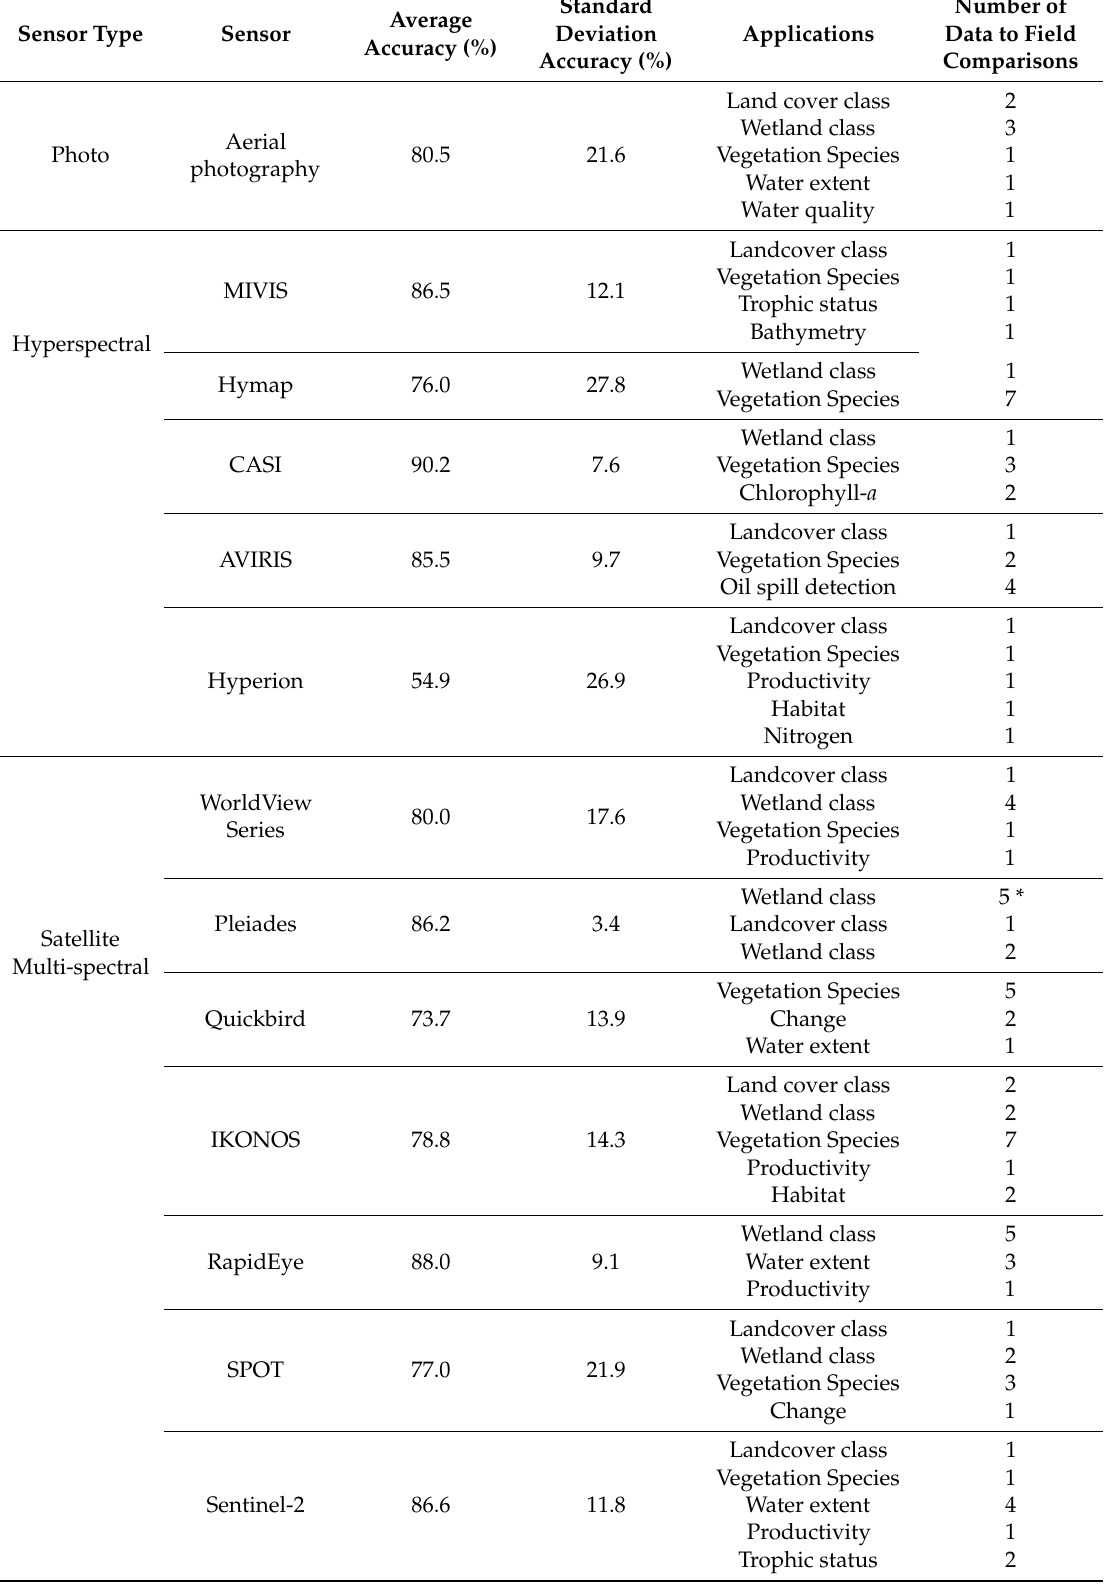
Table 2. Average, standard deviation, and number of data comparisons for combined applications compared with field data for each sensor from the literature for boreal wetlands. * Comparisons indicate that results were obtained from a single article (caution interpreting results should be